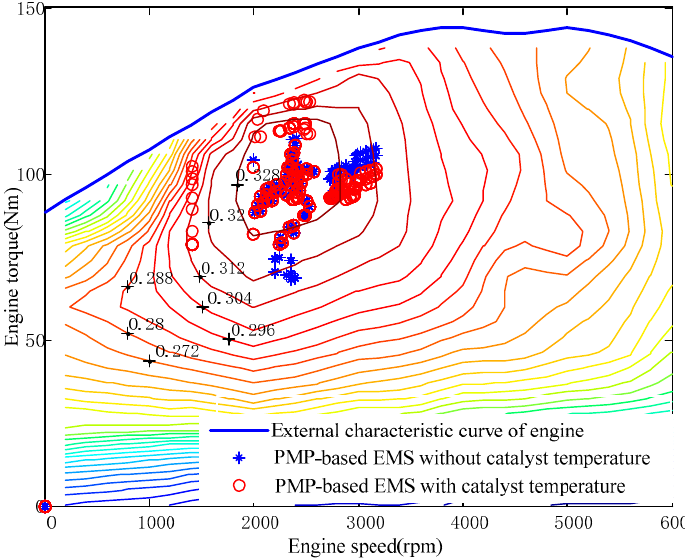
Figure 17. Engine working points under different EMS for eight repeated NEDC cycles.